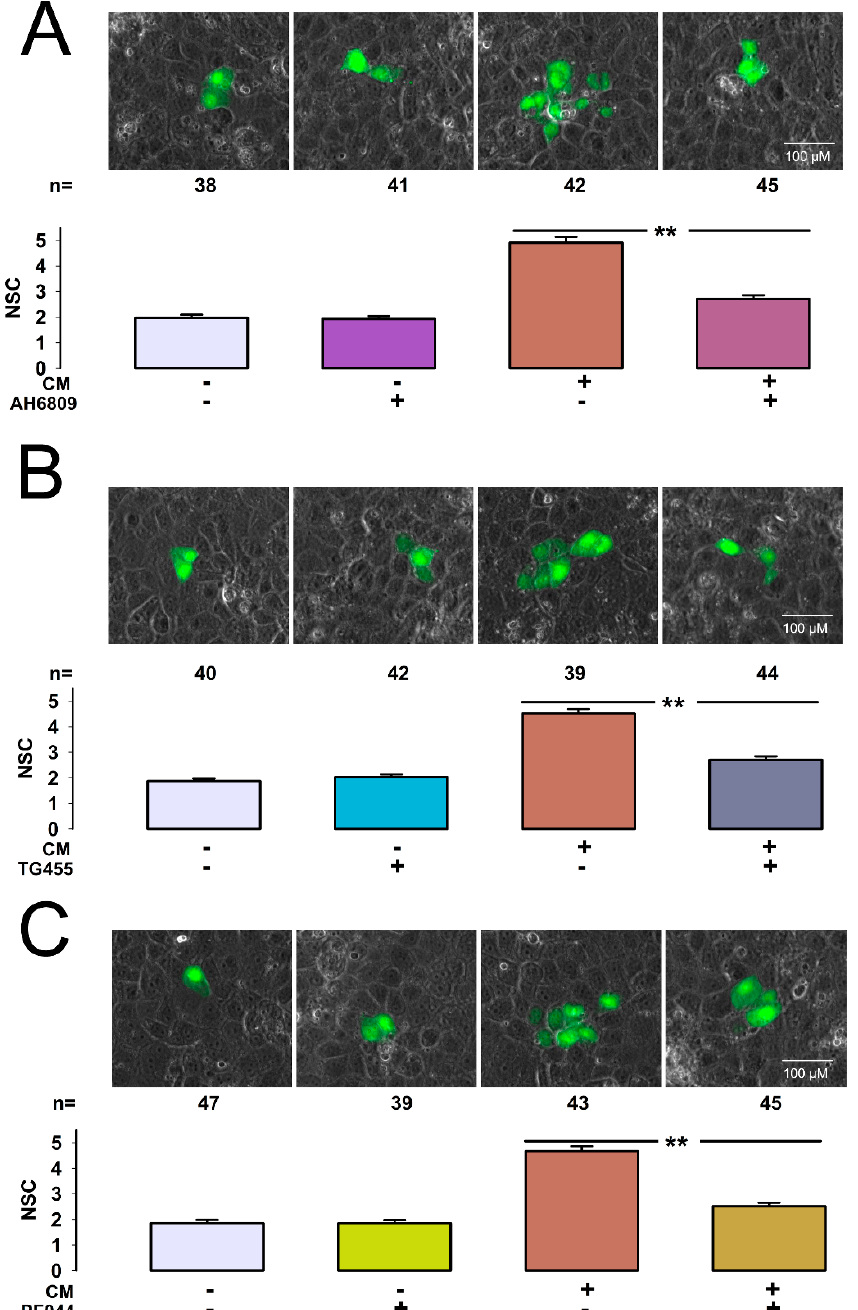
Figure 5. EP2 receptor antagonists abolish CM-induced enhancement of GJIC in MDCK-I cells. ( A – C ) sets show the effect of AH-6809 (AH), TG4155 (TG) and PF-04418948 (PF) respectively. The row of images, shown on each set, are representative images of dye transfer trials of the experimental condition shown at the bottom of the bar chart. The green mark corresponds to LY dye, whereas the gray background is a phase contrast field showing the integrity of the monolayer. The images were selected to match the median of each indicated experimental condition. The lower part of each set is a bar chart that compares the value of X SC ( ± SE) of each experimental condition indicated at the bottom of each bar. (**) indicates statistically significant difference ( p < 0.001) of the groups that separates the lines. The numbers shown above bars indicate the number of repetitions.